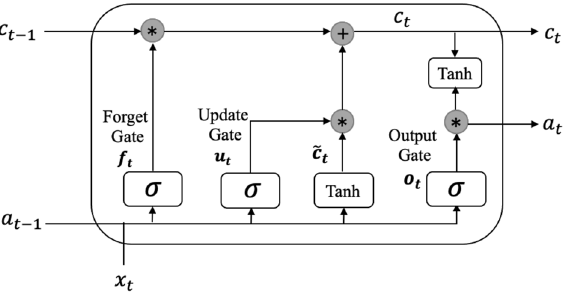
Figure 2. Structure of LSTM cell, which introduces three special gates: Input Gate (i), Forget Gate (f), and Output Gate (o). These gates determine what information to forget, what information to maintain, and how much to